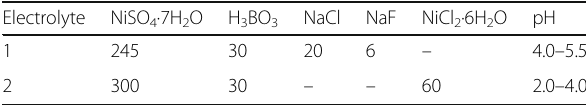
Table 2 Compositions of electrolytes, kg/m 3 Electrolyte